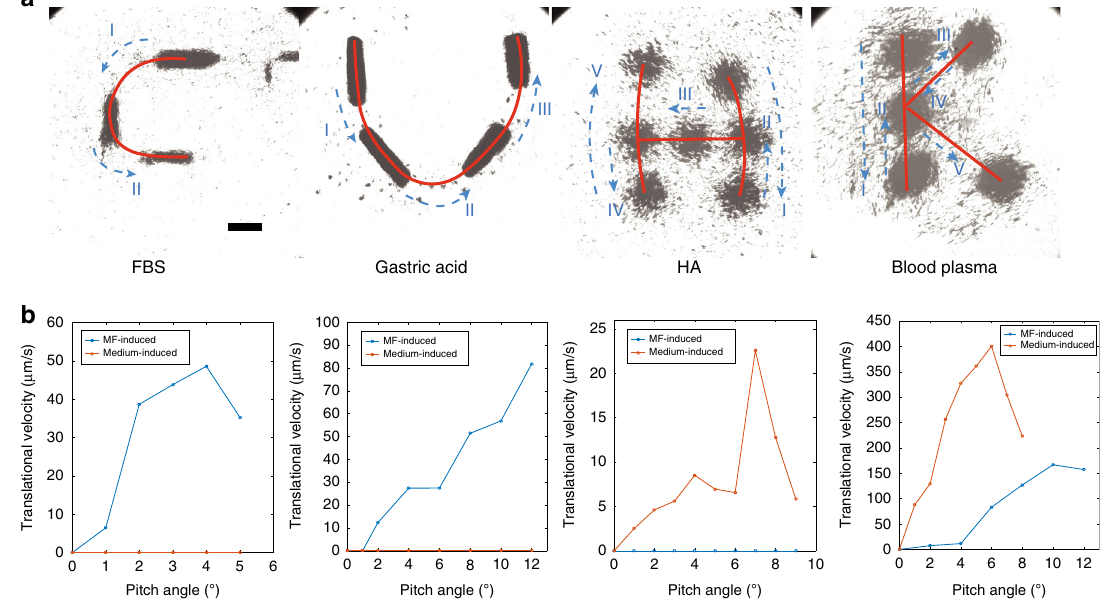
Fig. 5 Navigated locomotion of the MF-induced and the medium-induced swarms in different bio- fl uids. a The locomotion trajectories “ CU ” are from the MF-induced swarms in FBS and gastric acid, respectively; and the trajectories “ HK ” are from the medium-induced swarms in HA and blood plasma, respectively. The scale bar indicates 500 μ m. b The translational velocities of the swarms in different bio- fl